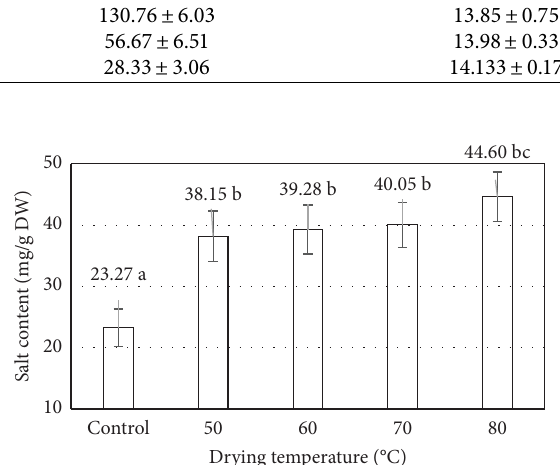
Figure 7: Efect of drying temperature on salt